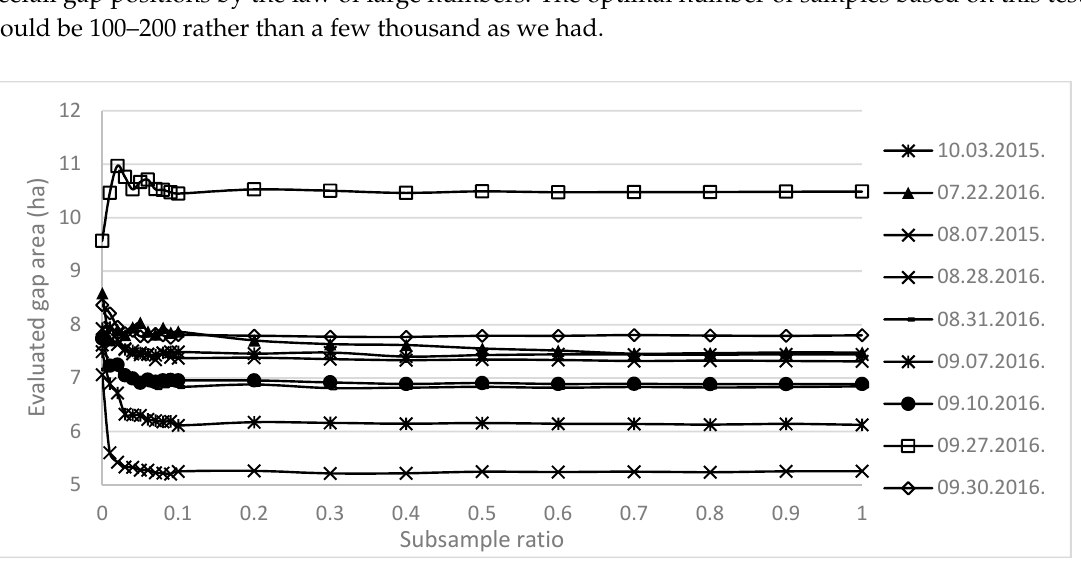
Figure 9. Area evaluation with randomly subsampled endmember sources on different dates.